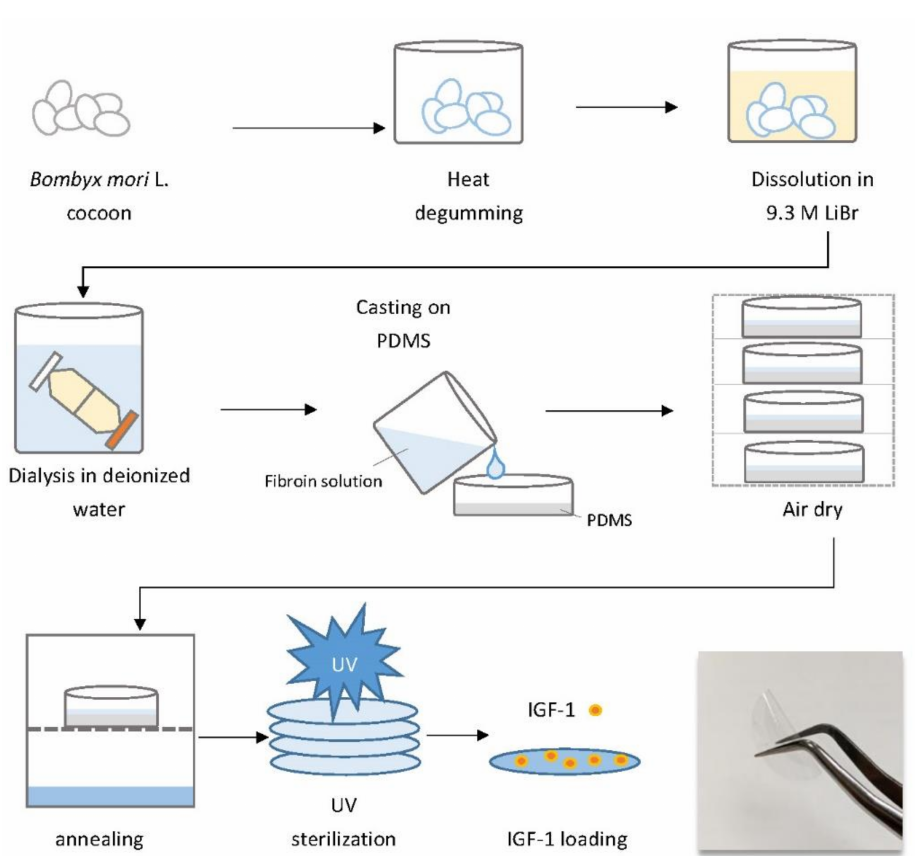
Figure 1. Schematic representation of the stepwise procedure of insulin-like growth factor 1 (IGF-1)- loaded silk fibroin film (IGF-1-loaded SF film)